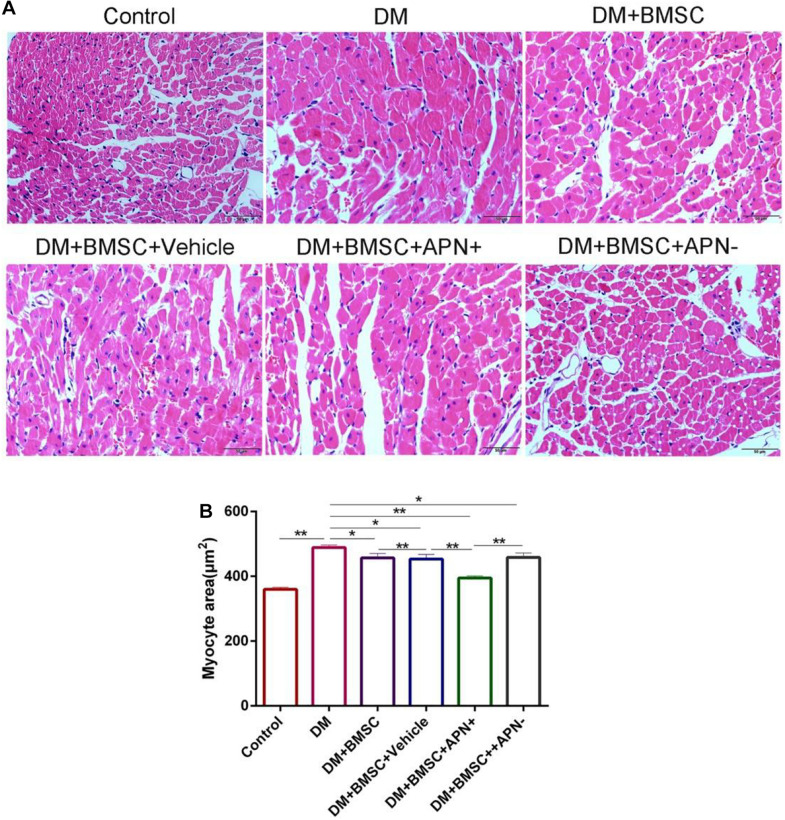
APN attenuated pathological changes in the hearts of diabetic rats. (A) Representative micrographs of myocardial tissue sections stained with hematoxylin and eosin (scale bar: 50 μm). (B) Quantitative analysis of myocyte size area. Data are mean ± SD; *p < 0.05, **p < 0.01.